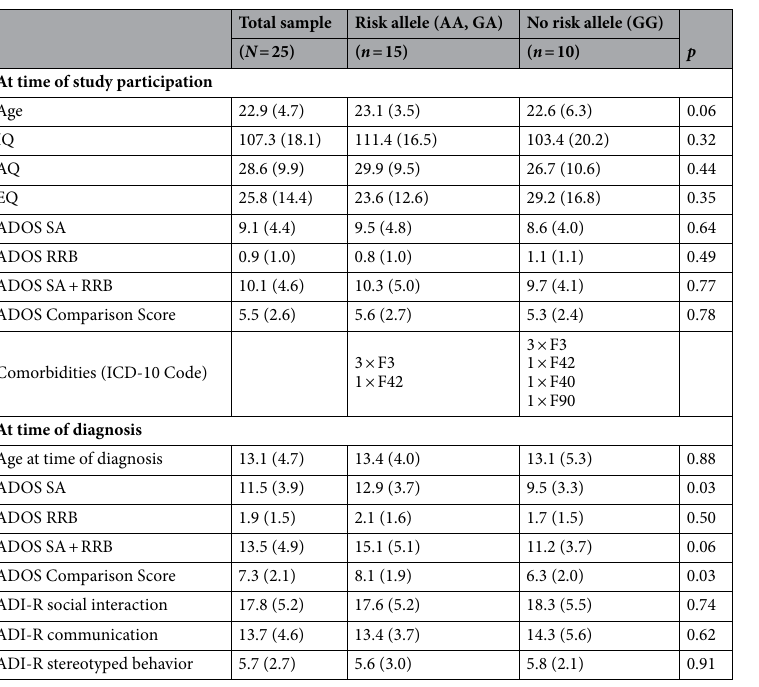
Table 1. Sample characteristics. Means, standard deviations (in parentheses) and between-group comparisons on clinical measures in risk allele carriers and non-carriers. AQ Autism Spectrum Quotient 65 , EQ Empathy Quotient 66 , ADOS Autism Diagnostic Observational Schedule 61,67 , ADOS SA ADOS Social Affect Score, ADOS RRB ADOS Repetitive and Restricted Behavior Score, ADI-R Autism Diagnostic Interview-Revised 62 . p -values derive from two-sample t -tests comparing carriers of the risk allele A (AA, GA) to non-carriers